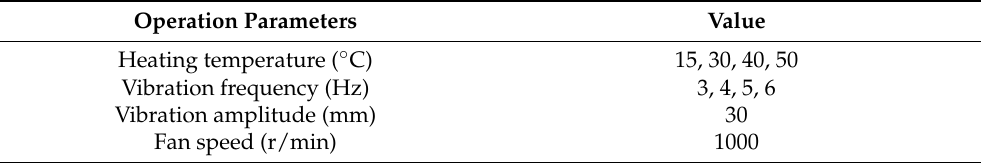
Table 2. Experimental